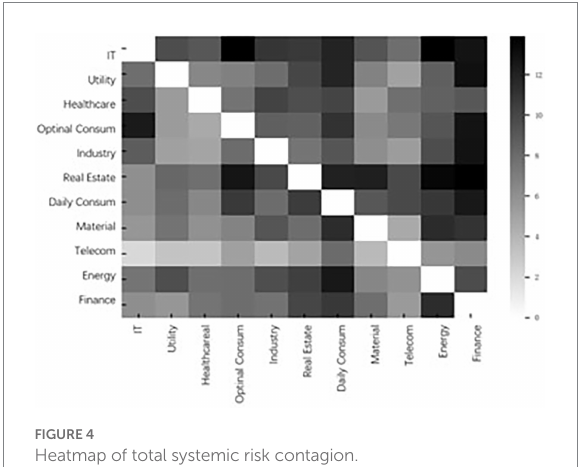
FIGURE 4 Heatmap of total systemic risk